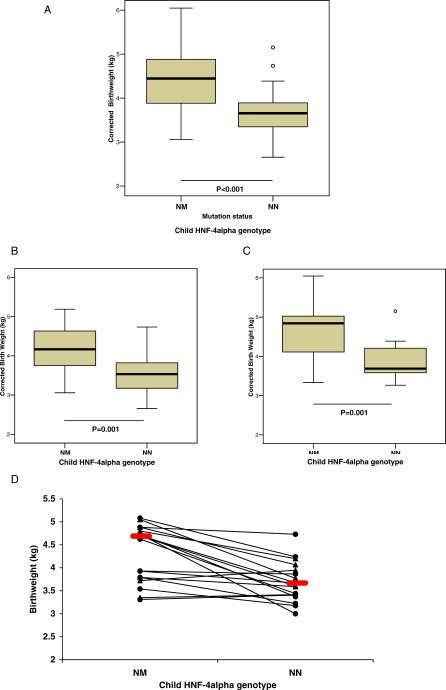
Birthweight (Adjusted for Sex and Gestational Age) according to Foetal Genotype(A) All offspring; (B) HNF4A mutation inherited from the father; (C) HNF4A mutation inherited from the mother, and (D) siblings discordant for HNF4A genotype.Foetal genotype: NM, heterozygous HNF4A mutation; NN, normal HNF4A. For (A) to (C), bars represent median, the box represents interquartile range, and the whiskers represent the range, with outliers shown as circles. Comparing NM birthweight with NN birthweight by Mann-Whitney U-test: p < 0.001 for (A) all offspring; p = 0.001 for (B) father affected and for (C) mother affected. In (D), those pairs where the father has the mutation are shown as filled circles; those pairs where the mother has the mutation are shown as filled triangles. The red bars represent median birthweight.